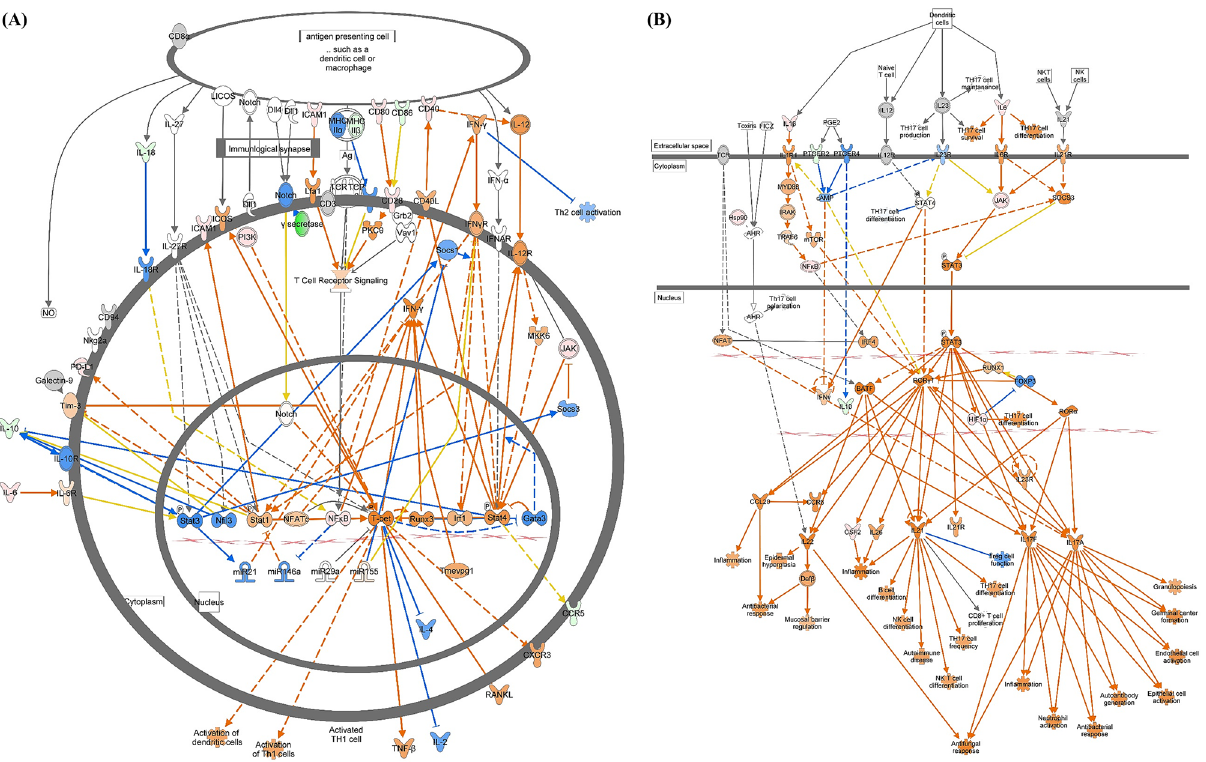
Figure 3. Ingenuity pathway analysis of the T helper cell response in M. intracellulare -infected canine MDMs. ( A ) The Th1 Pathway and ( B ) Th17 Activation Pathway were expressed at 72 h post infection. The individual nodes represent proteins with relationships represented by edges. The red and green colors indicate up- and downregulation based on the expression values, respectively. The activation states by z-scores are shown as follows: orange indicates activation, blue indicates inactivation, and uncolored nodes indicate genes that were not differentially expressed in this